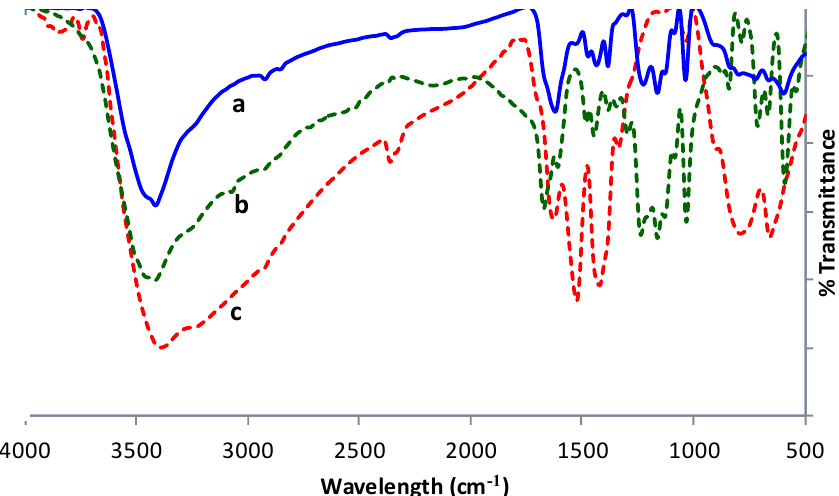
Fig. 2. FTIR spectra of samples. (a) 5-SA-TiO2; (b) 5-SA; (C)